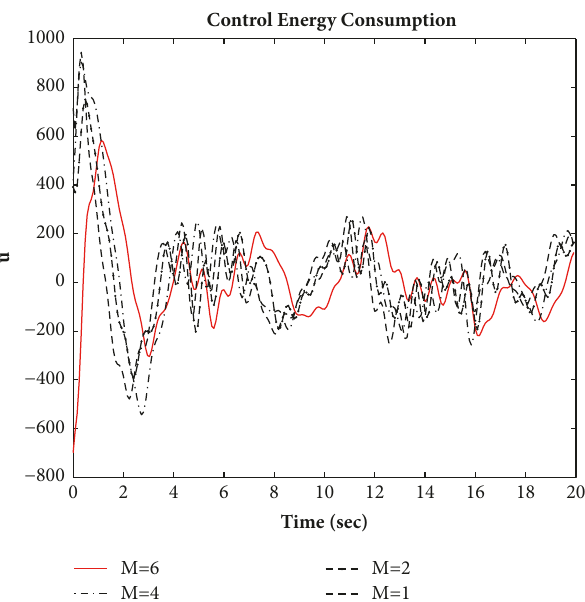
Figure 7: The curve of the control energy consumption 𝑢(𝑡)